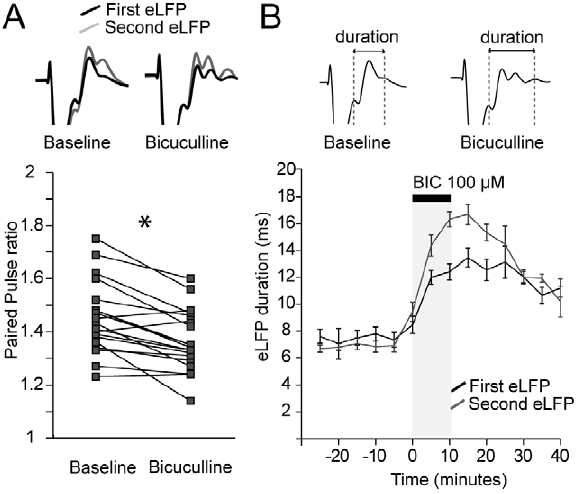
Figure 9. Intrastriatal bicuculline infusion does not block paired pulse facilitation and enhances field response duration. A. Paired pulse ratio (interstimulus interval 50 ms) of the amplitude of the evoked field potentials during baseline and after bicuculline. Top traces: superimposed average traces of the first and second evoked field potentials during baseline and bicuculline condition. Paired pulse facilitation was not blocked by bicuculline indicating that paired pulse facilitation is not due to differential effects of GABAergic neurotrans- mission during the first and second stimulation pulse. N=3 experi- ments. * p , 0.05 Student’s paired t test. B. The overall duration of the striatal field potentials was determined as the time between the first positive peak P1 of the field response and the positive peak of the last supplementary response. During baseline condition, the duration of the first and second evoked potential was comparable. After 10 minutes of bicuculline infusion the overall duration of the first evoked potential was increased 65 6 7% whereas the second was increased 146 6